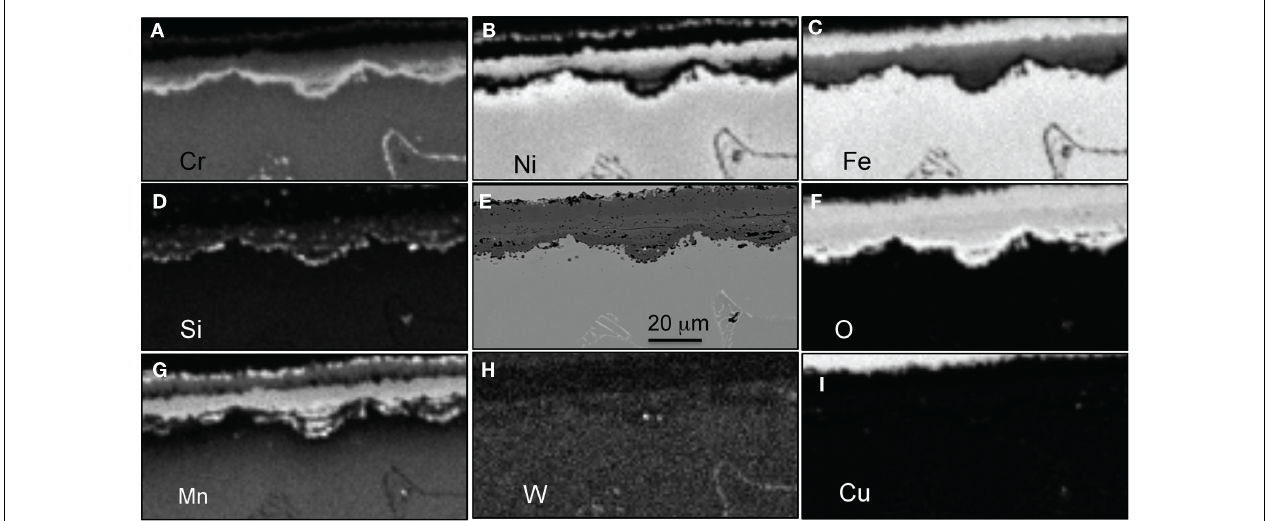
FIGURE 14 | EPMA mapping for alloy CF8CWCu-2 exposed for 5000h in air +++ 10%H 2 O at 800°C, (A) Cr, (B) Ni, (C) Fe, (D) Si, (E) SEM picture, (F) O, (G) Mn, (H) W, and (I) Cu .